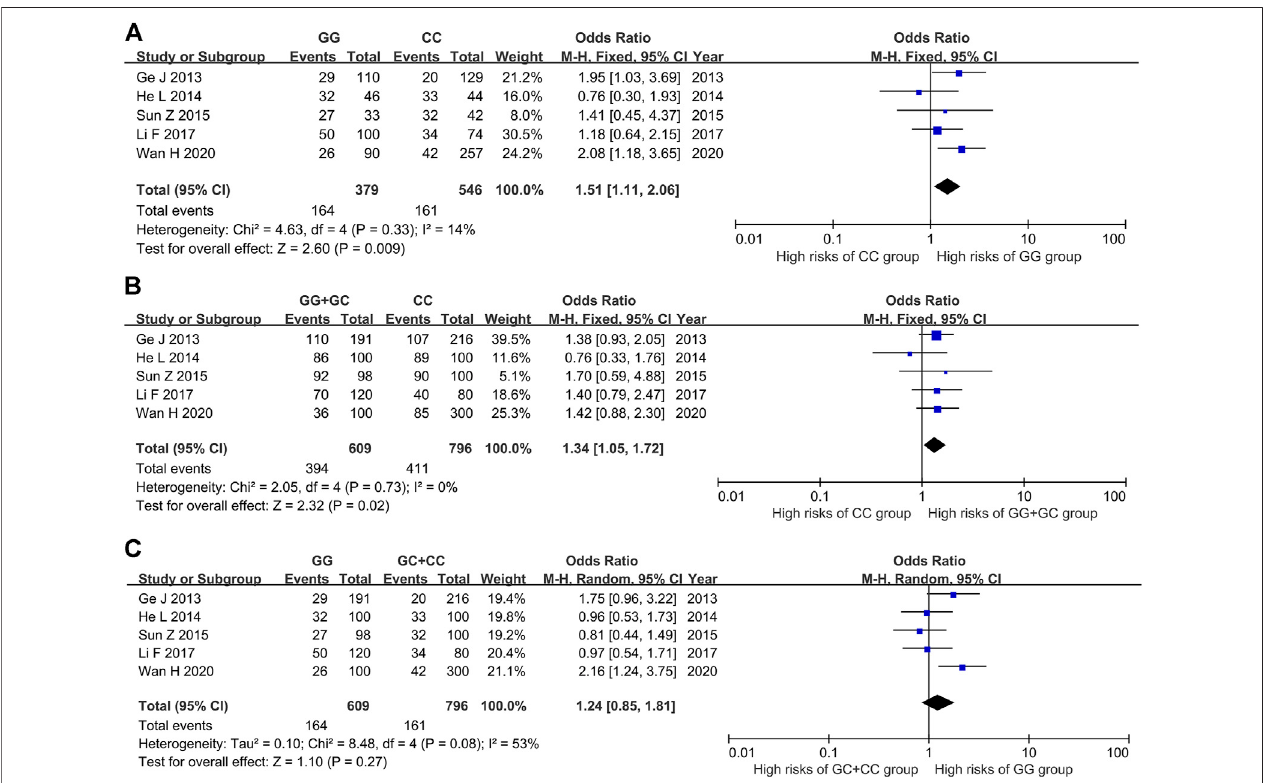
FIGURE 3 | Meta-analysis of correlation between PTPN22 gene SNP1123 and ITP. (A) GG vs CC. (B) GG + GC vs CC. (C) GG vs GC + CC.